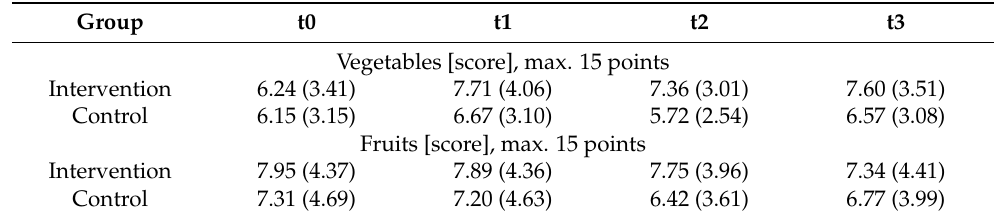
Table 3. Descriptive statistics of components of the HEI-NVS (ITT analysis) 1